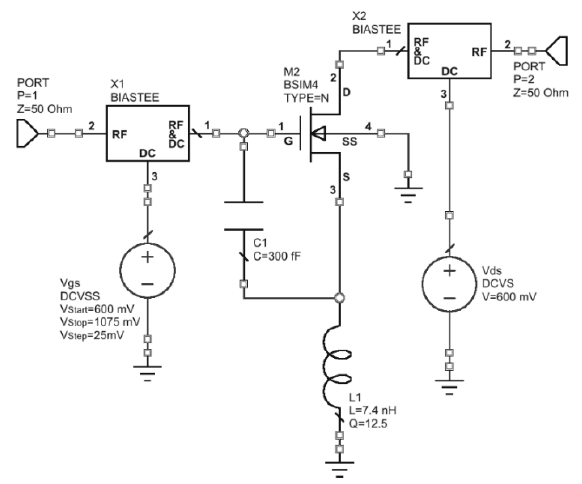
Figure 9. Common source (CS) stage schematic circuit used for characterization.